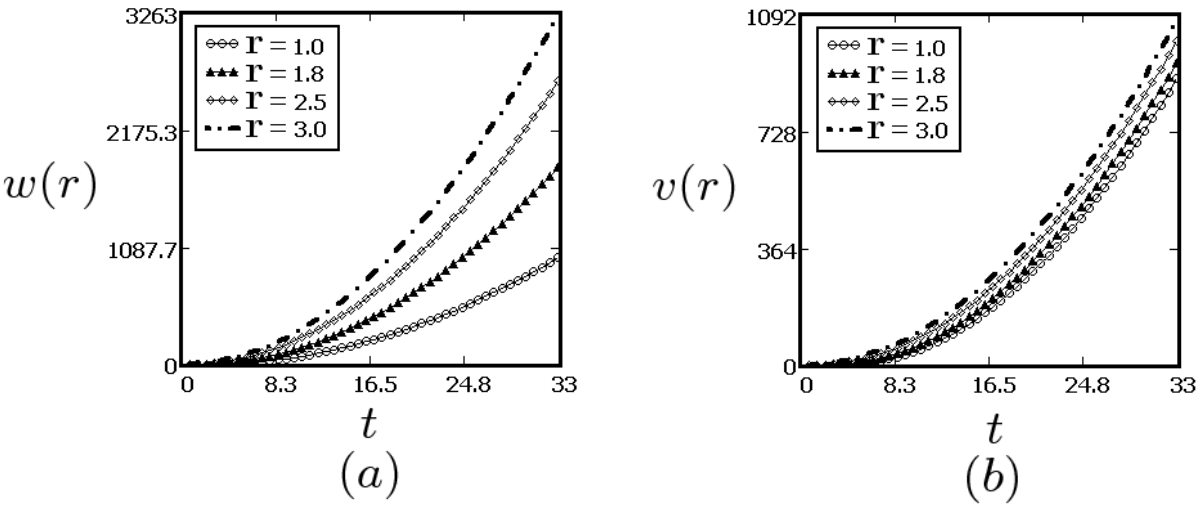
Fig. 3: Profiles of the velocity components w ( r , t ) and v ( r , t ) given by Eqs. (32) and (33), for R = 3, Ω = 1, U = 1, ν = 0.9292, µ = 26, λ = 3, α = 0.5, p = 2 and different values of r